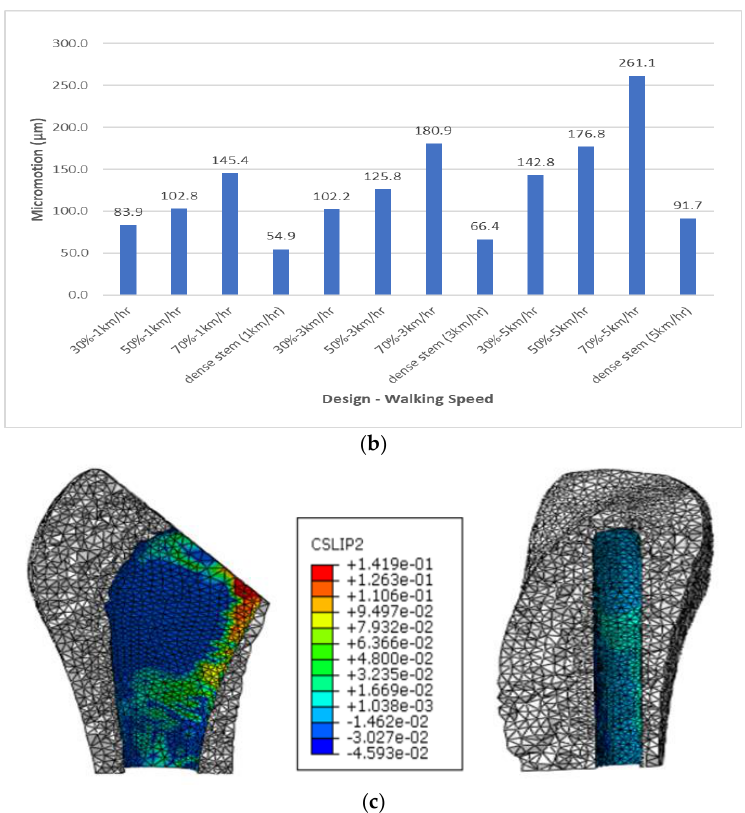
Figure 13. ( a ) Maximum micromotion and ( b ) average micromotion of the designed FG stems vs. the bulk stem at 1, 3, and 5 km/hr walking speeds. ( c ) Graphical representation of micromotion in the bone (typical example).